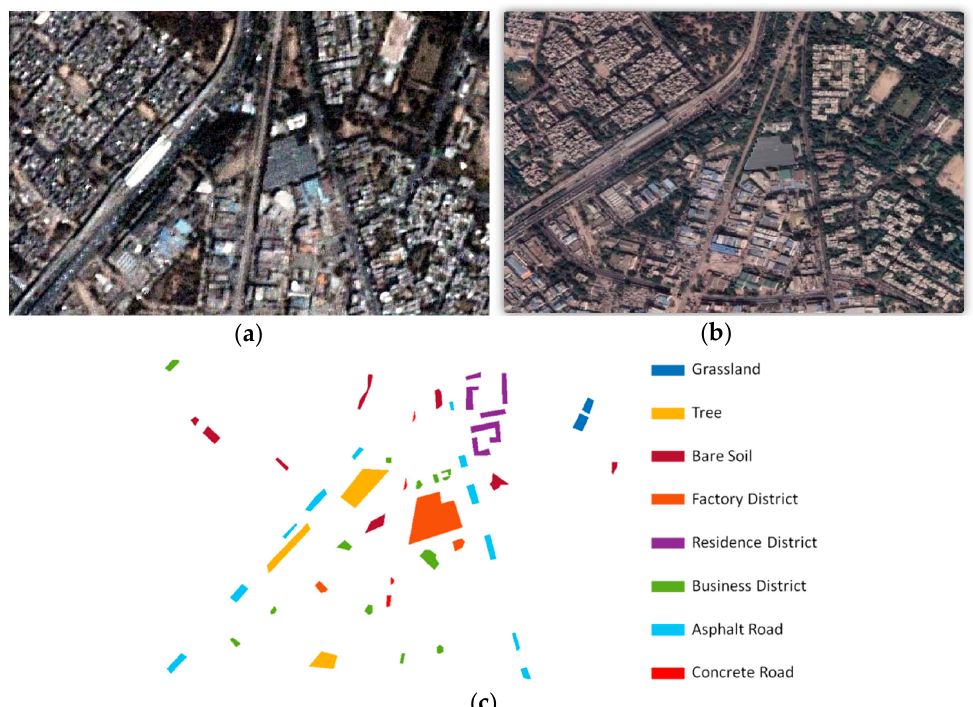
Figure 1. Experimental image and ground-truth data ( a ) and the corresponding image obtained from the satellite video remote sensing data ( b ). The reference satellite-derived remote sensing data from Google Earth ( c ) and the labeled ground truth data.